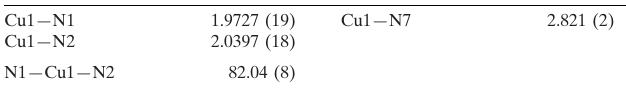
Selected geometric parameters (A˚ , (cid:2)